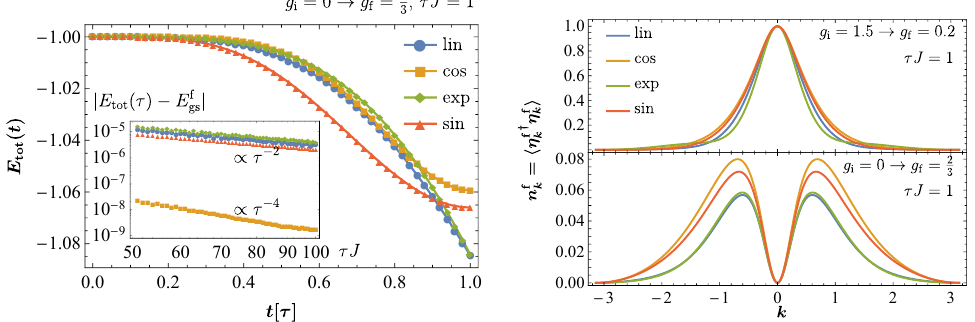
( t ) during a quench from g = 0 to g = 2 over τ J = 1 tot i f 3 = 0 to g = 2 and varying durations i f 3 . Right: gs of the final Hamiltonian at t = τ for quenches between phases (upper k